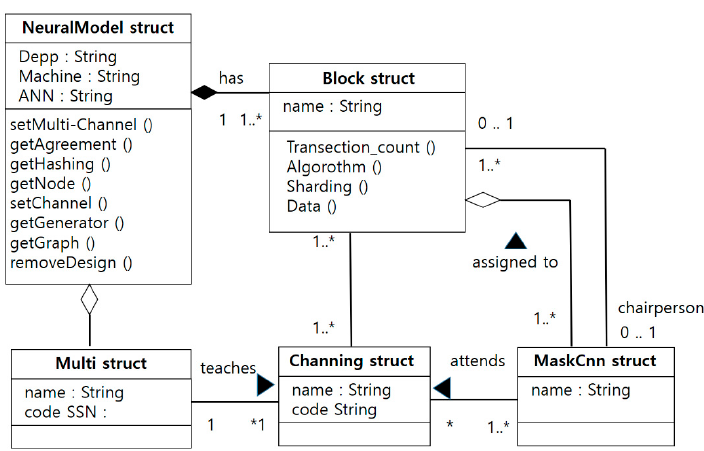
Figure 7. Validated unified modeling language (UML) for class diagram.